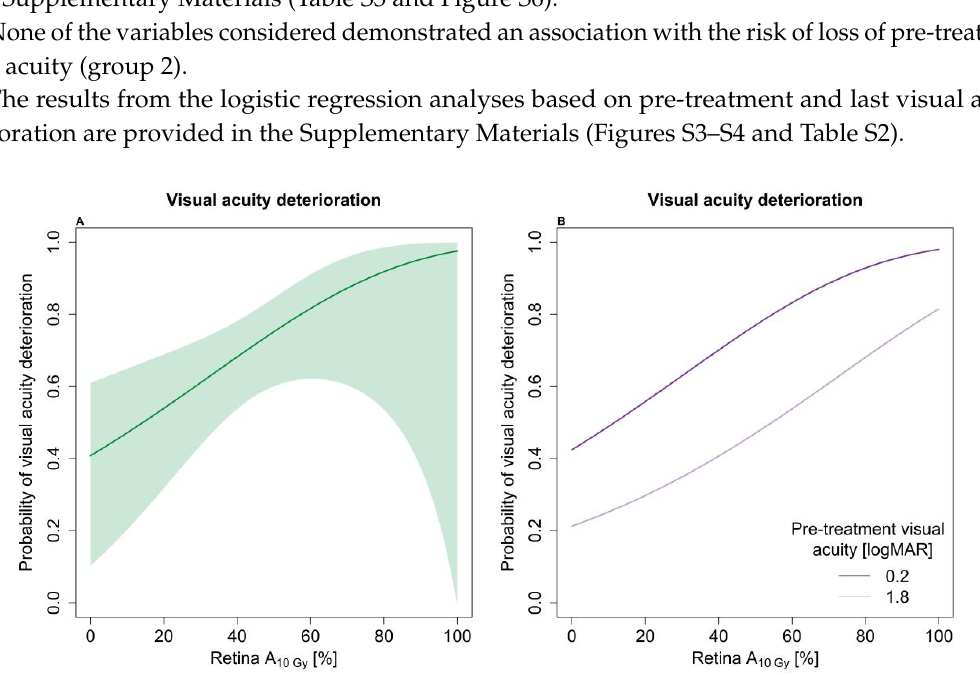
Figure 2. ( A ) Dose–response of visual acuity deterioration as a function of the area of the retina receiving 10 Gy (retina A 10Gy ). The model adjusts for optic disc–tumour distance (2.4 mm), pre-treatment visual acuity (0.3 logMAR), macula V 20Gy (89%), and macula A 80Gy (8%). The shaded area indicates the 95% confidence intervals. ( B ) Dose–response of visual acuity deterioration as a function of retina A 10Gy for two pre-treatment